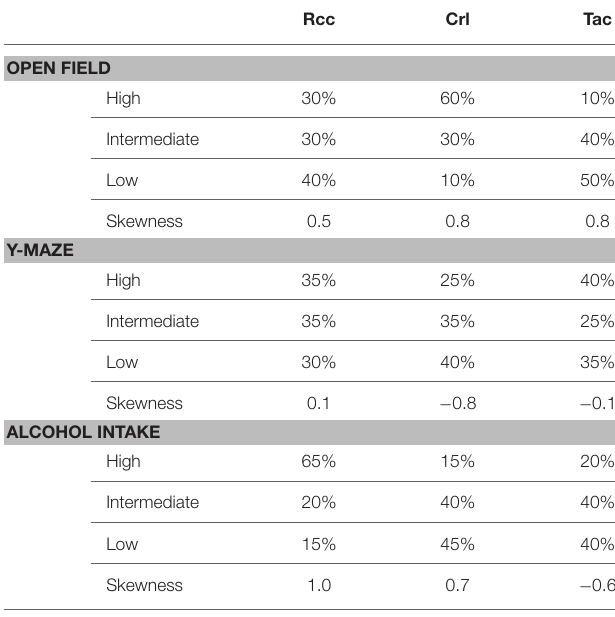
Formation of subgroups based on a tertiary split of percentage duration in the inner zone of the OF, level of correct alternations in the Y-maze and voluntary alcohol intake prior to naltrexone in Wistar rats from three different suppliers, i.e., RccHan TM :WI (Rcc), Crl:WI (Crl), and HanTac:WH (Tac). Data are presented as the distribution of animals from a tertiary split into groups of high, intermediate and low for each